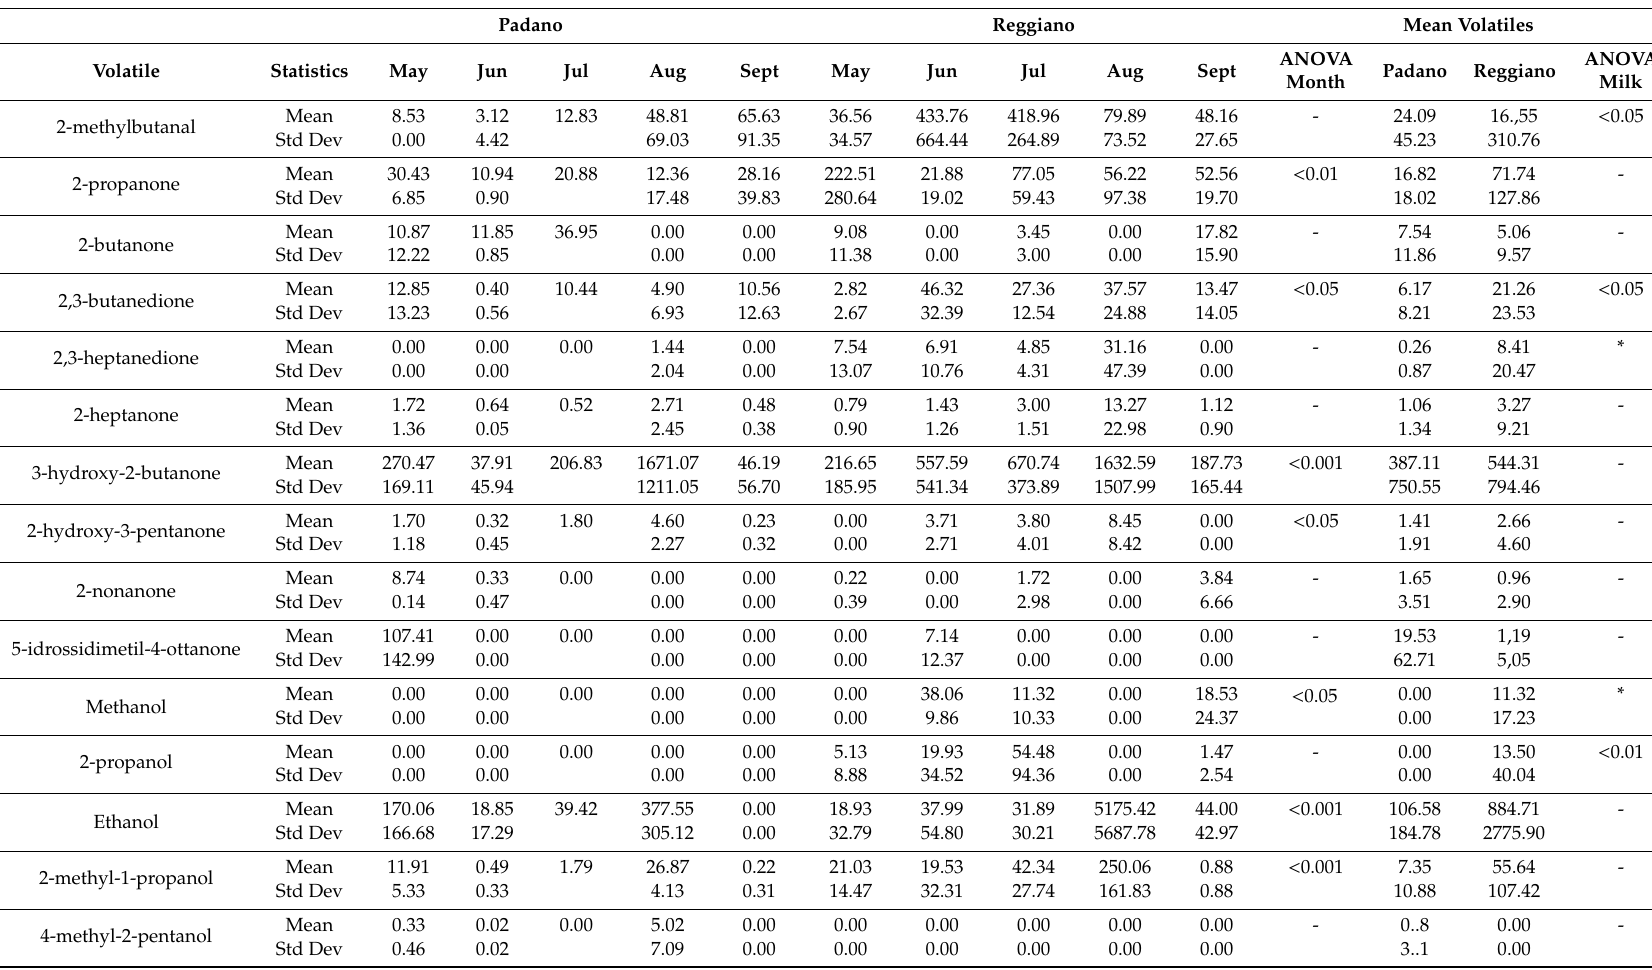
Table 4. Descriptive statistics and two-way ANOVA results for the volatile molecules in Reggiano and Padano destined milks. The asterisks indicate significance with p between 0.05 and